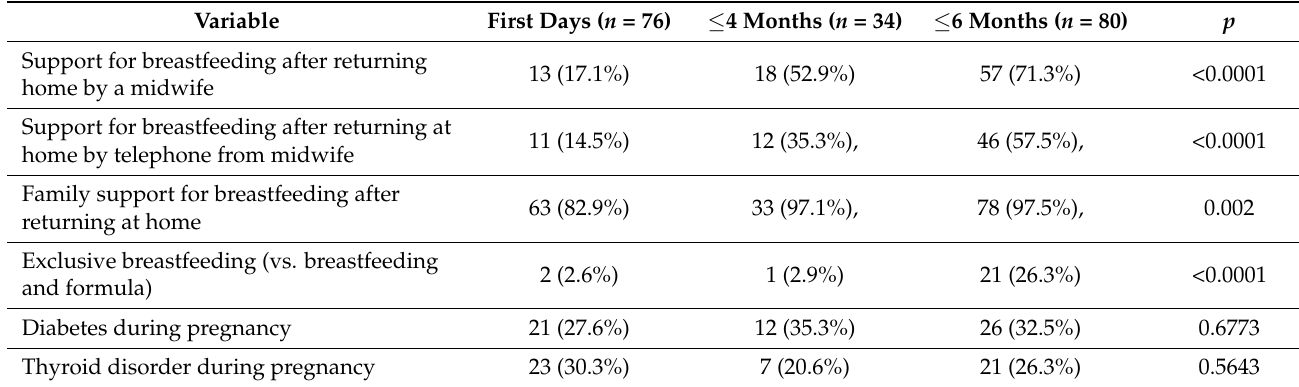
Table 4. Factors associated with breastfeeding